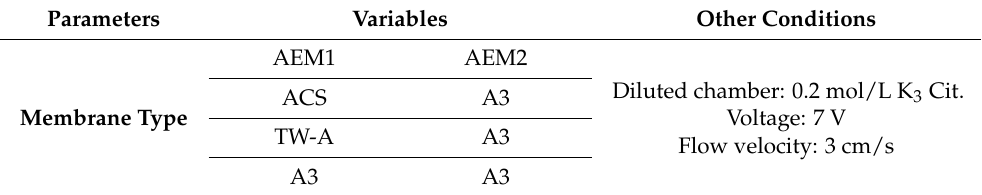
Table 1. Experimental parameters to be investigated for the electrodialysis – metathesis process.